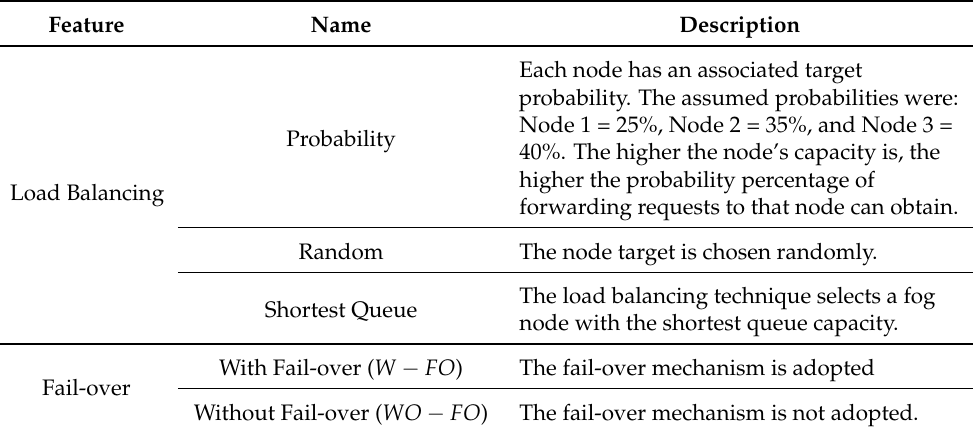
Table 5. Combinations of load balancing techniques and fail-over mechanisms to reduce request losses and enhance response time.